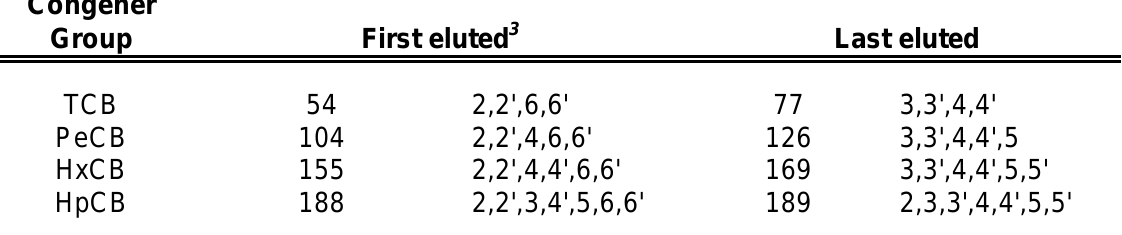
Table 5. GC Retention Time Window Defining Solution and Congener Specificity Test Standard 1,2 (Section